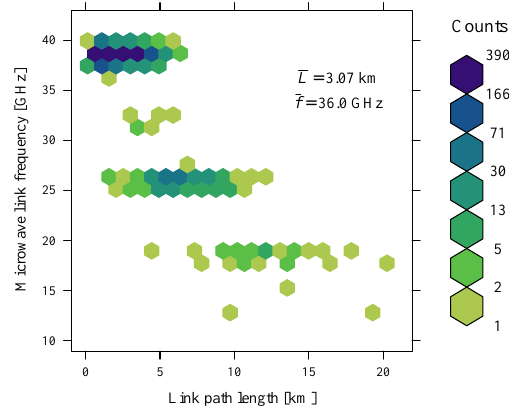
Figure 2. Scatter density plot of microwave link frequencies vs. link-path lengths for the 12-day validation period. The colour scale is